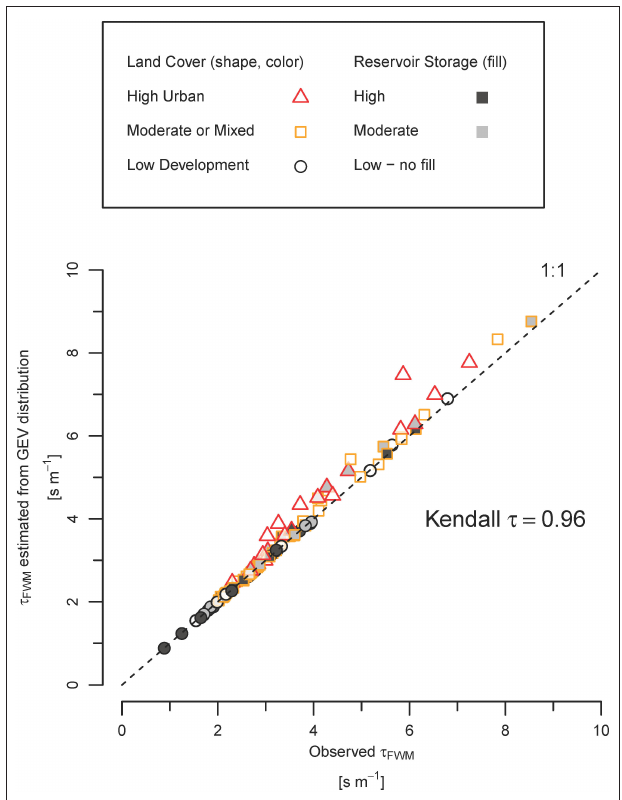
FIGURE 7 | Flow-weighted mean travel time ( τ ef ) calculated from the observed streamflow distribution and a GEV distribution fit to each stream using